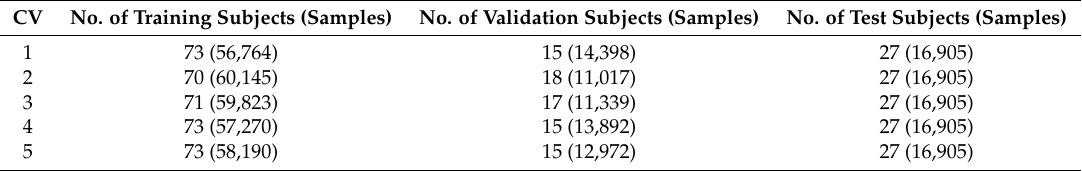
Table 1. Split of the